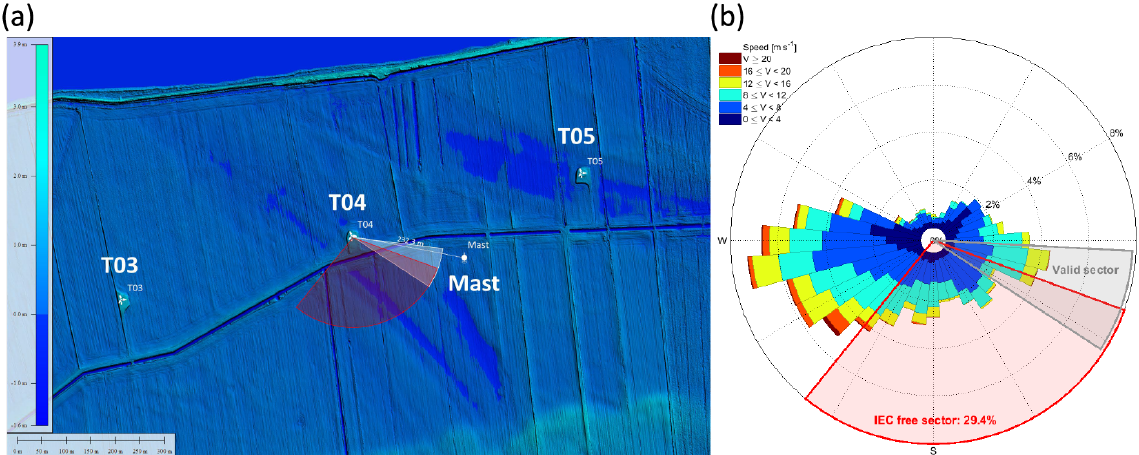
Figure 3. (a) Elevation map in the vicinity of T04, Nørrekær Enge wind farm. Map: DHM/terrain (0.4m grid). Source: Styrelsen for Dataforsyning og Effektivisering. (b) Wind rose during the NKE campaign, measured by the top-mounted cup anemometer and wind vane.